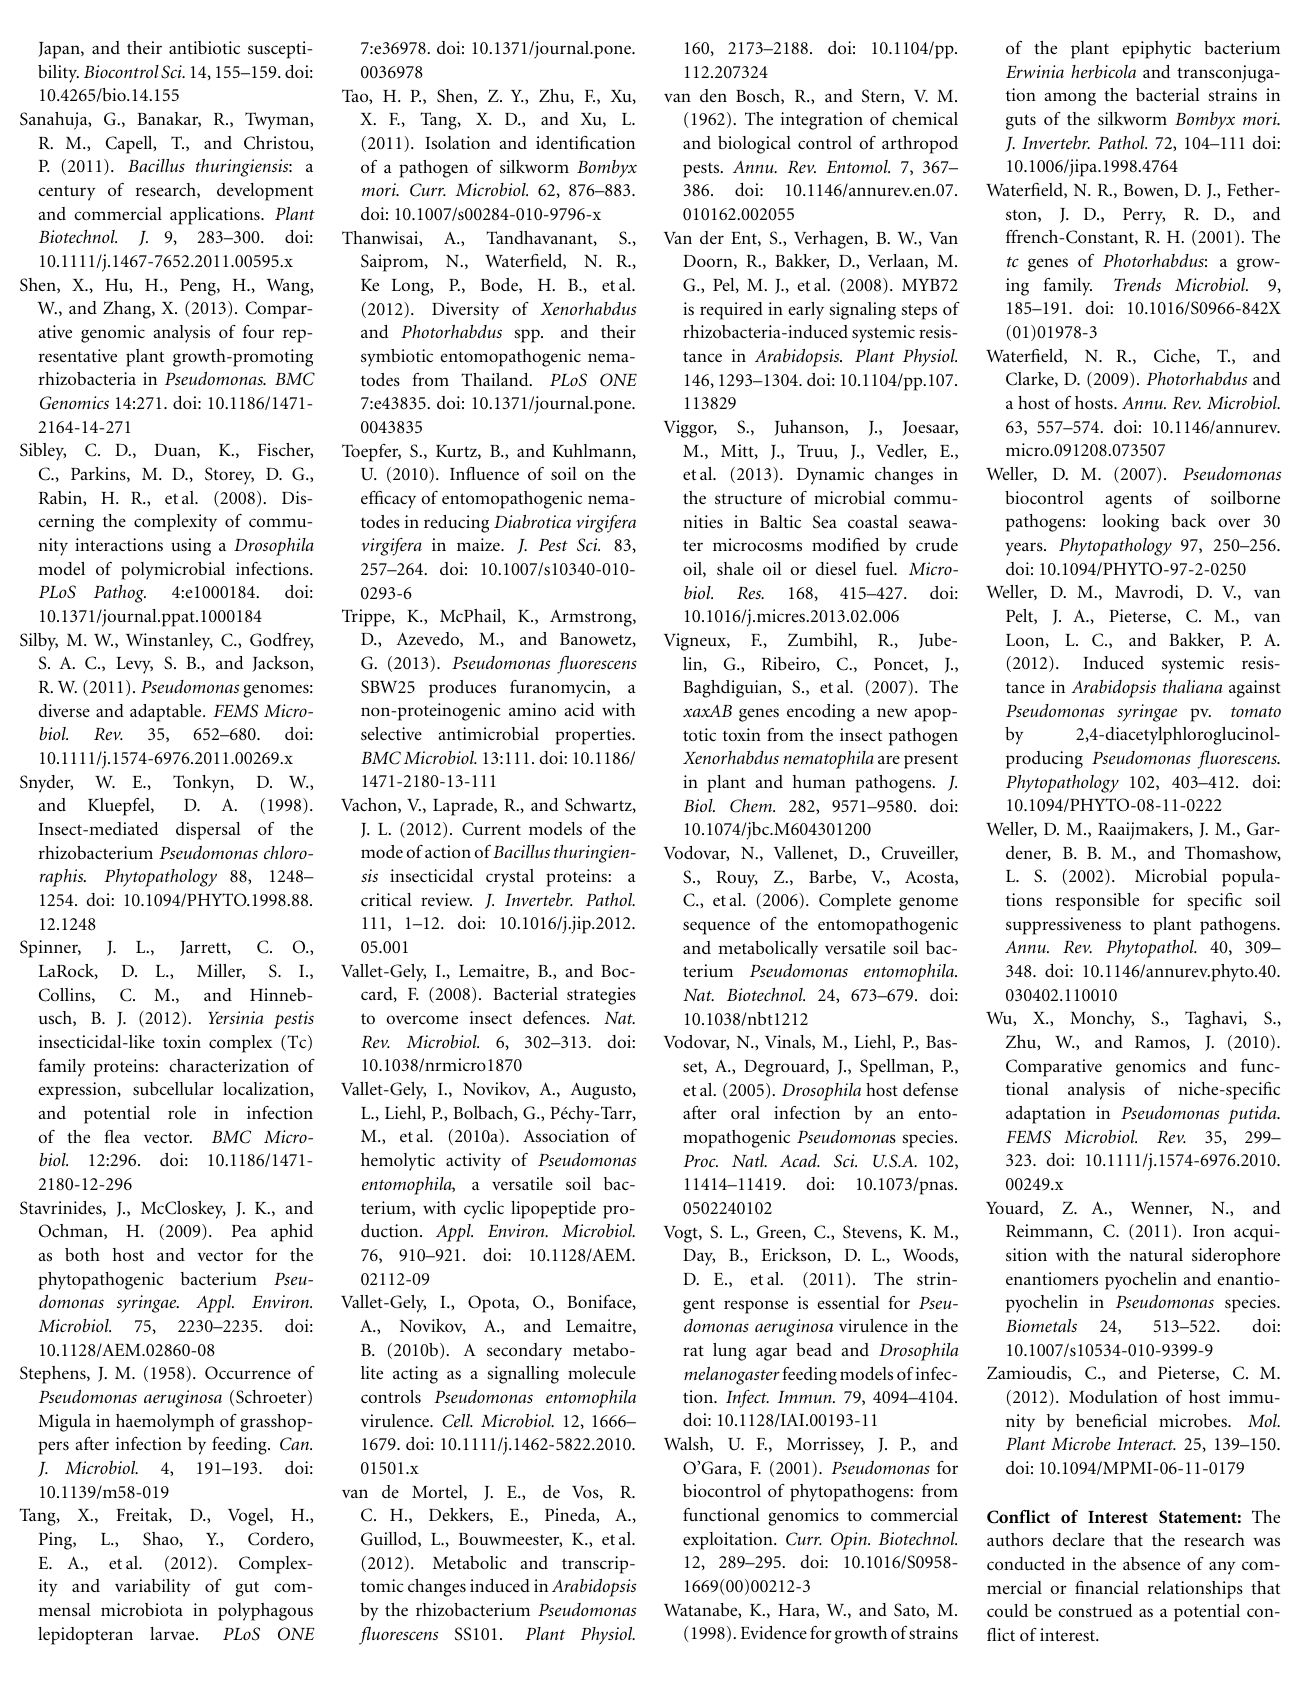
could be construed as a potential con- flict of